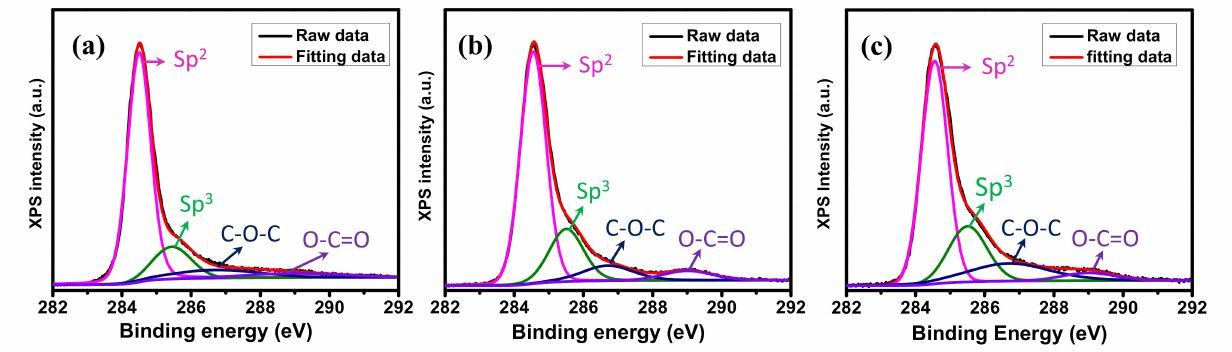
Figure 3. X-ray photoelectron spectroscopy (XPS) C 1s spectra of ( a ) the planar graphene, ( b ) the GM V-5, and ( c ) the GM